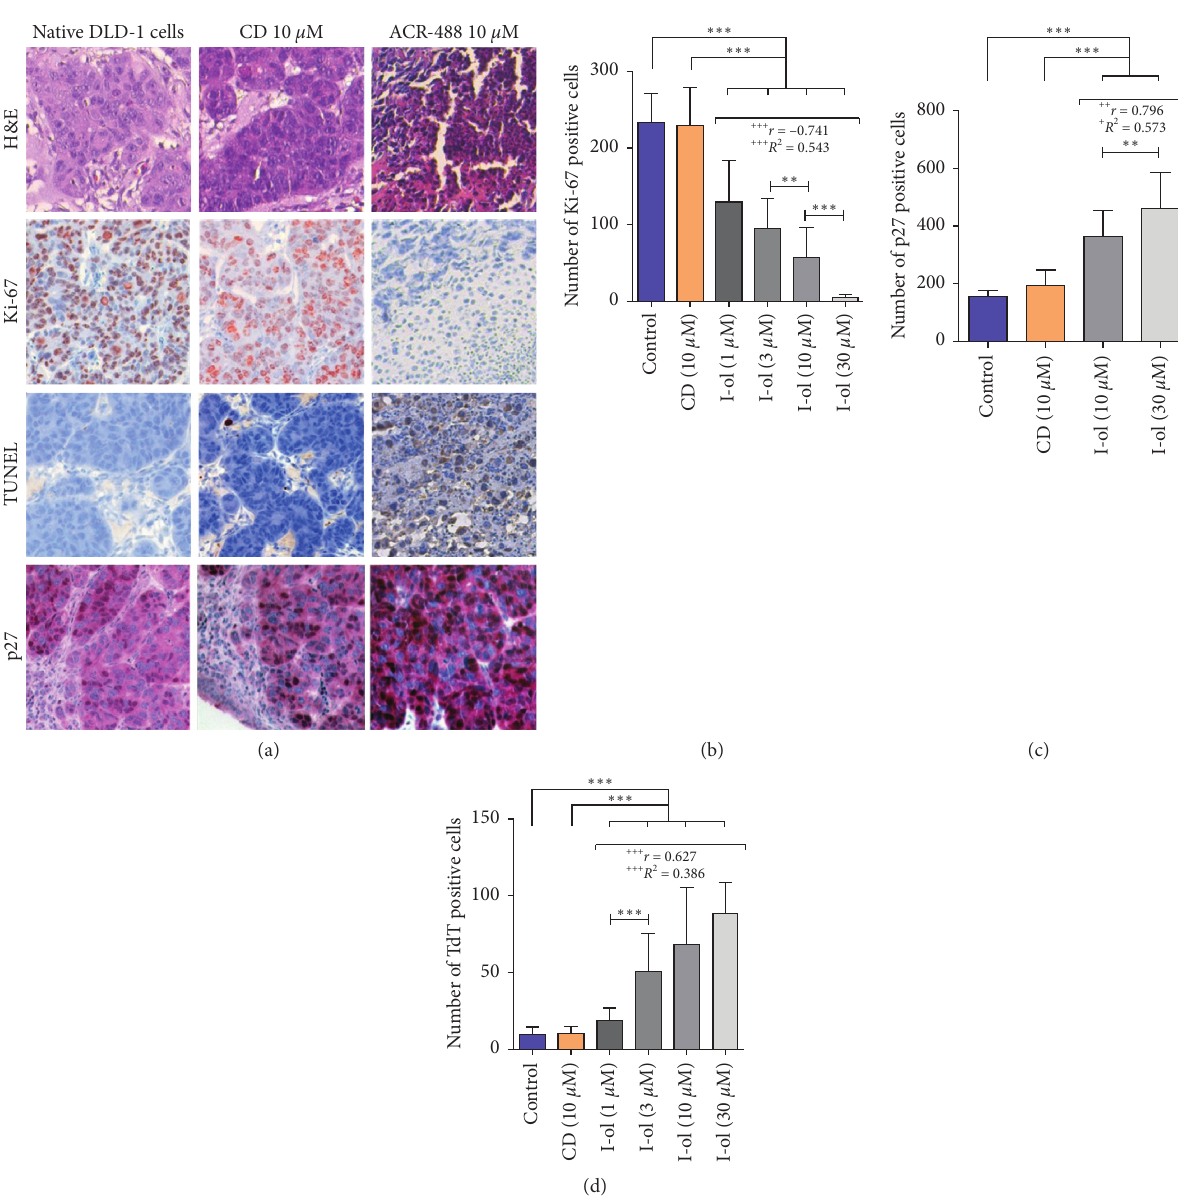
Figure 6: DLD-1 cell growth into CAM tissues. (a) Representative images of H&E staining, Ki-67 and p27 immunohistochemistry, and TUNEL assay results. The magnification of the objective lens was 20-fold, and that of the ocular lens was 10-fold, such that the total magnification was 200-fold. (b) A gradual reduction of Ki-67-positive cells was observed with increasing I-ol concentrations. (c) Induction of p27 protein expression. (d) Linear increase in the number of apoptotic cells, compared with the control groups. The results are shown as the mean ± SD. Statistical calculations were performed based on two-way mixed ANOVA, followed by Bonferroni’s post hoc test. In all cases, the significance level was ∗ p < 0 . 05 (significant), ∗∗ p < 0 . 01 (highly significant), or ∗∗∗ p < 0 . 001 (very highly significant). Dose-dependent effects of I-ol were calculated by determining Pearson’s correlation coefficient ( r ) and performing linear-regression analysis (adjusted R 2 ), with the following statistical parameters: + p < 0 . 05 (significant), ++ p < 0 . 01 (highly significant), and +++ p < 0 . 001 (very highly